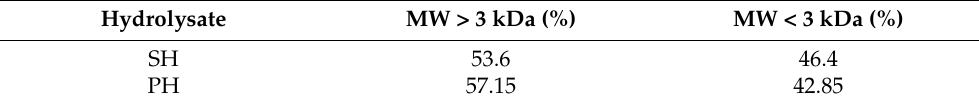
Figure 1. The total ion chromatogram (TIC) of the soybean (SH, ( A )) and pea (PH, ( B )) hydrolysates, respectively. The mass spectrometer ran for 70 min. Most of the SH sample peptides were eluted between 20 and 40 min, while the PH peptides were mostly eluted in 30–40 min. Table 1. Molecular weight distribution of SH and PH